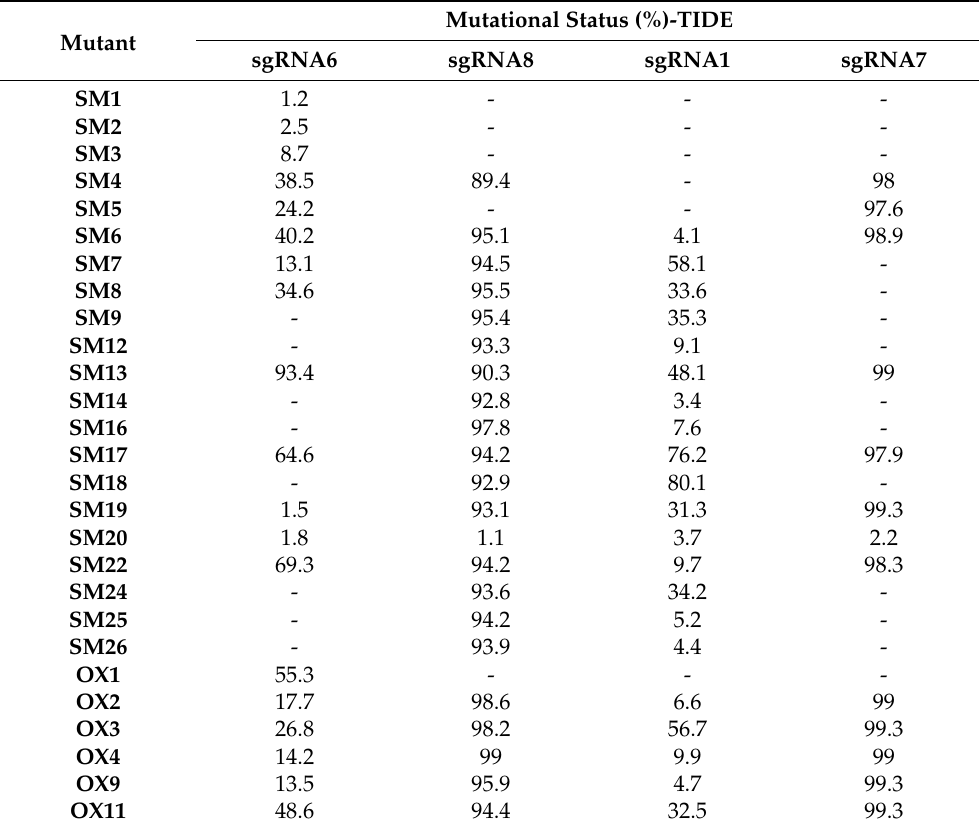
Table 1. Mutational status of the edited genotypes, as revealed by the TIDE analysis of the Sanger sequences. Four regions surrounding the adopted sgRNA were